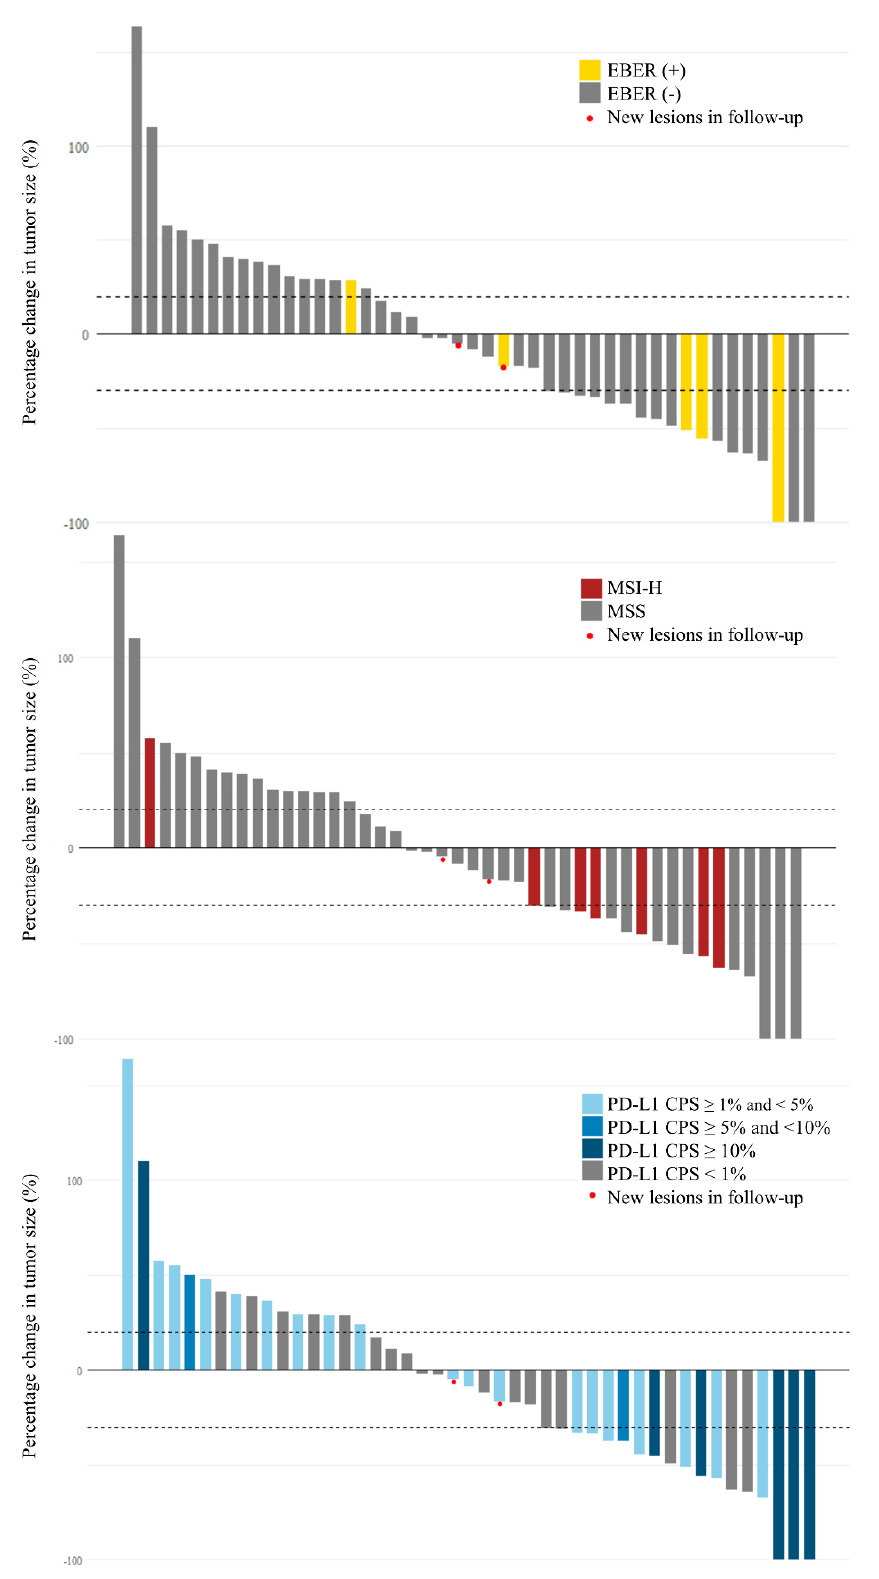
Figure 1. Waterfall plot for percentage change in tumor size with different biomarkers. EBER: Epstein–Barr virus-encoded small RNAs; MSI-H: high microsatellite instability; PD-L1: programmed death ligand 1; CPS: combined positive score; PD: progressive disease.